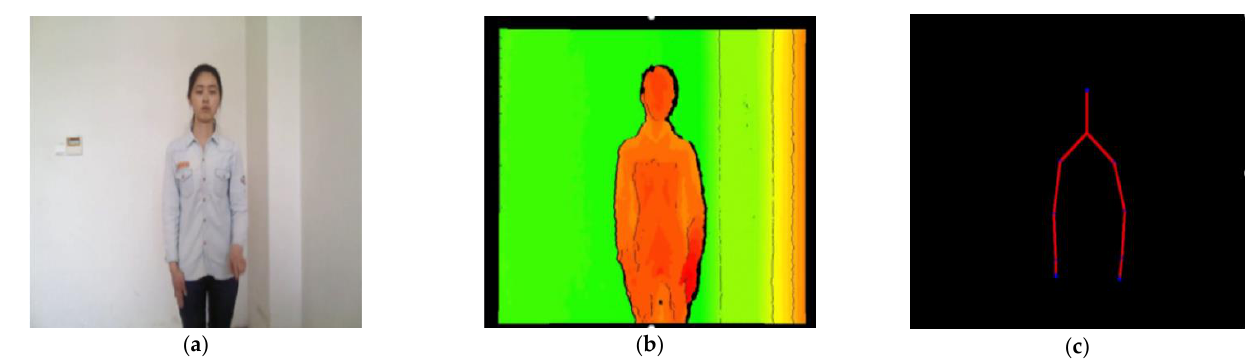
Table 3. Details of the DEVISIGN-L dataset.